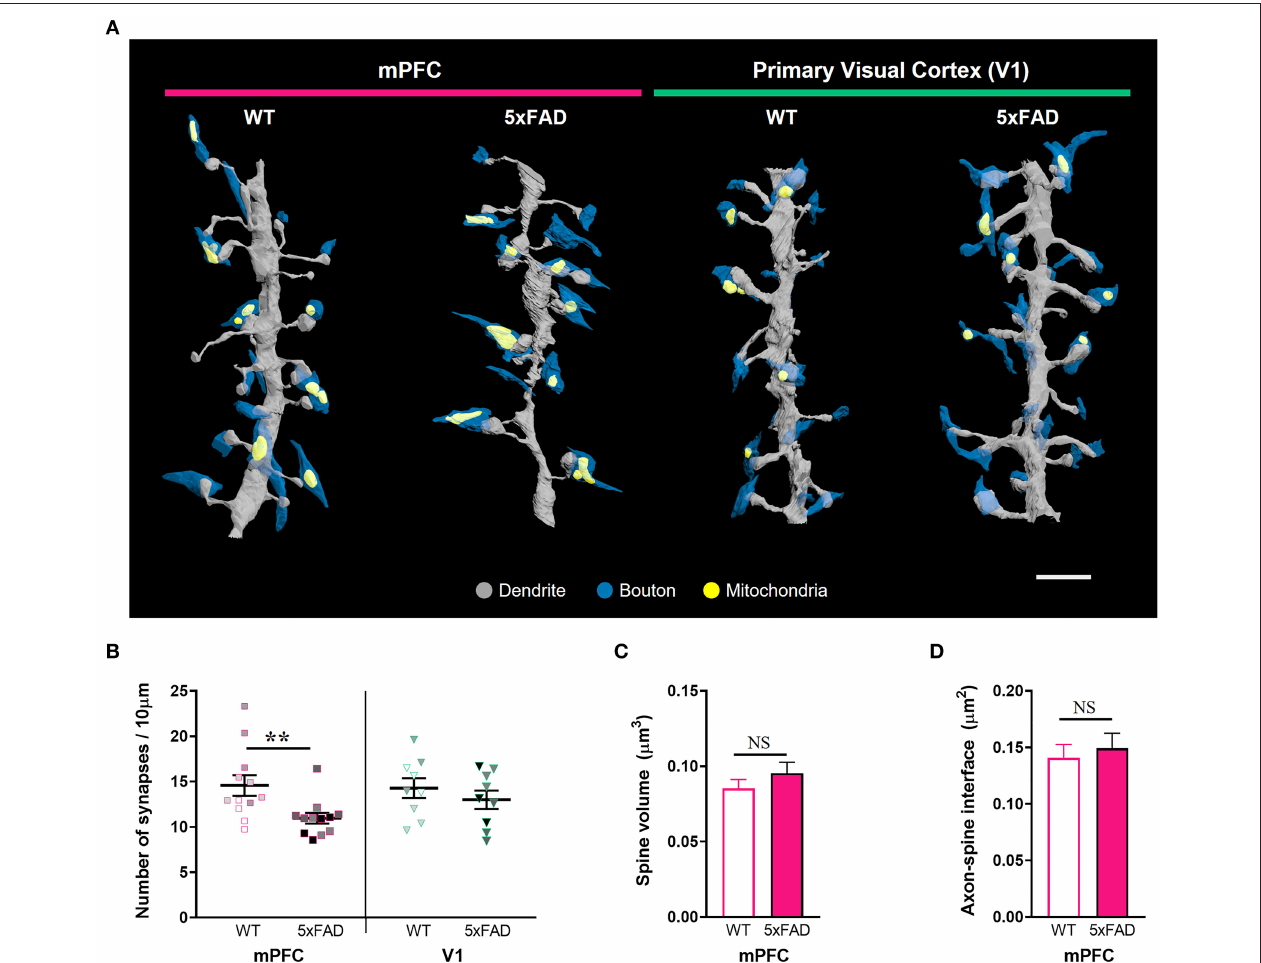
FIGURE 2 | Synapse loss in the mPFC, but not V1, of 6-month-old 5xFAD mice. (A) 3D reconstruction of SB-SEM images showing representative dendritic segments in the mPFC and V1 of WT and 5xFAD mice. Gray, dendrite; blue, presynaptic boutons; yellow, mitochondria. Scale bar, 2 µ m. (B) Quantification of synapse density in the mPFC and V1 of WT and 5xFAD mice, respectively ( n = 12 dendrites for mPFC and 9 dendrites for V1 per group). ** P < 0.01; Kruskal–Wallis test with post-hoc Dunn test. NS, not significant. The data points from each animal were displayed in the same color. (C,D) Quantification of average spine volume ( C , n = 228–289 spines per group) and ASI area ( D , n = 188–251 synapses per group) in the mPFC of WT and 5xFAD mice. NS, not significant. Mann-Whitney U